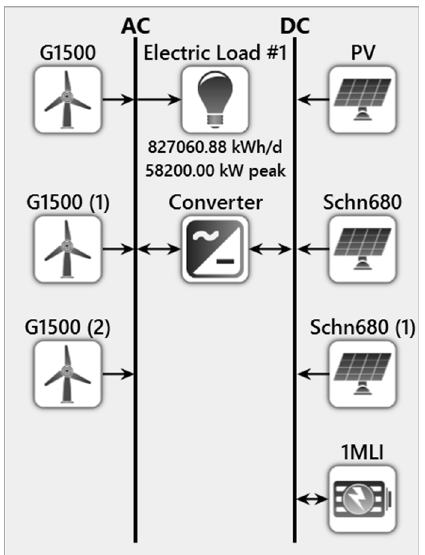
Figure 10. Schematic diagram of wind-PV-battery System.